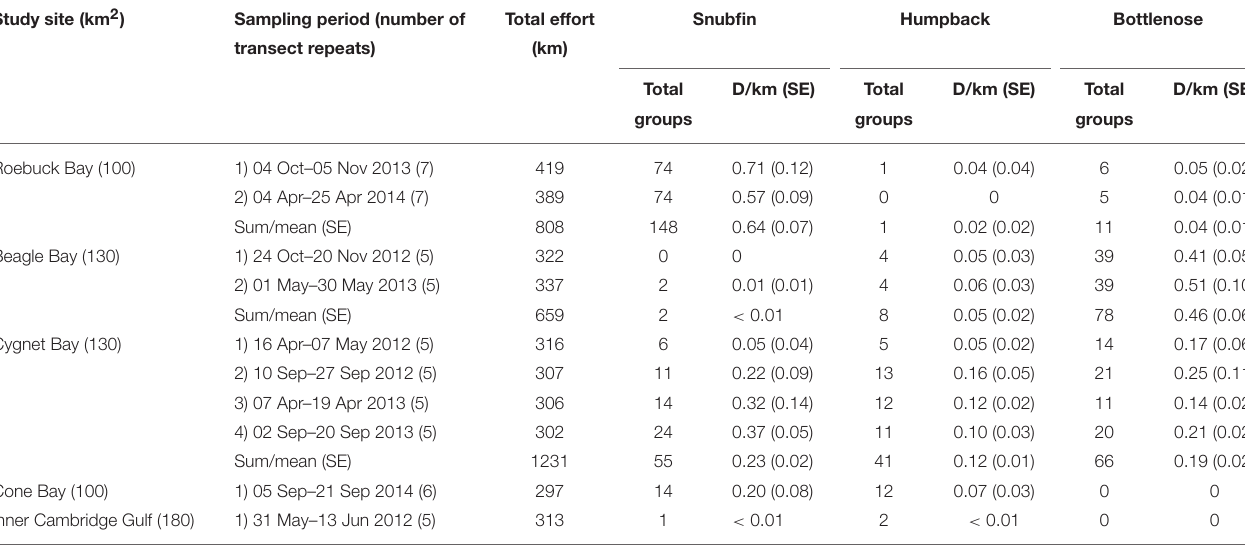
TABLE 3 | Survey effort, and number of groups observed and encounter rate of snubfin, humpback, and bottlenose dolphins per site, species, and sampling period. Study site (km 2 )